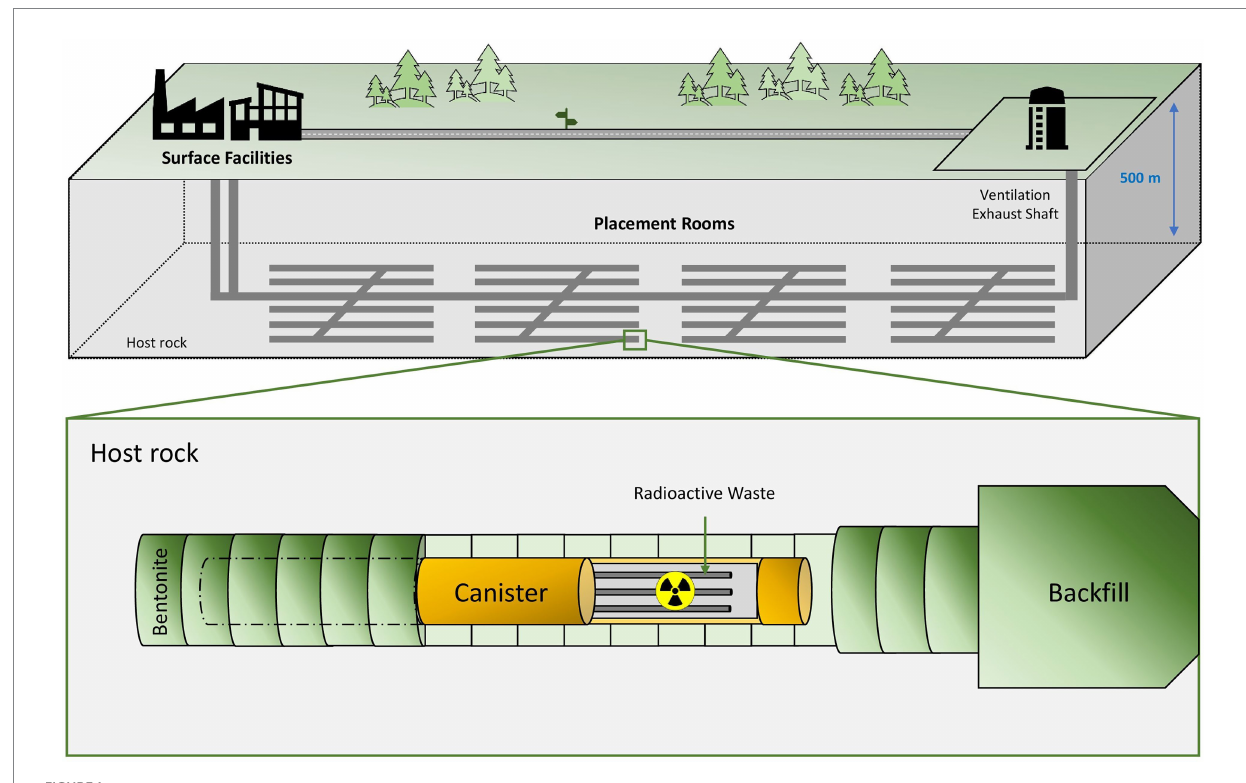
FIGURE 1 Diagram of the deep geological repository system according to the Nuclear Waste Management Organization